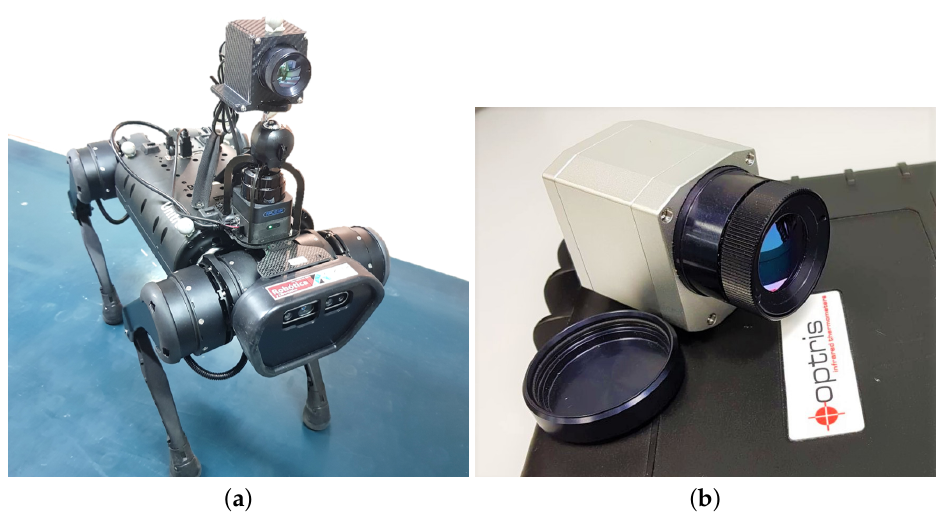
Figure 2. Robot and instrumentation used for the proposed method validation. ( a ) Unitree A1 Robot equipped with thermal camera and Real-Sense. ( b ) Optris Pi640 Thermal